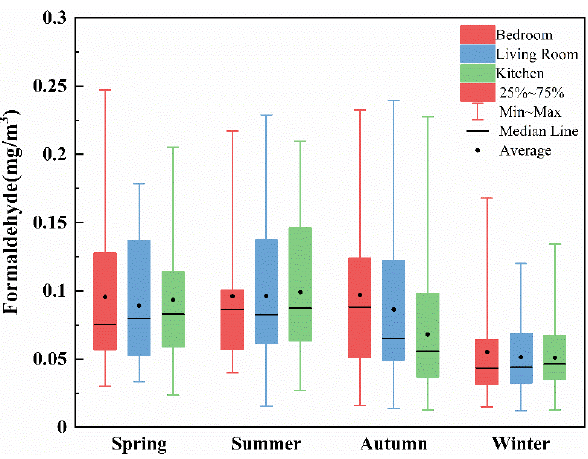
Figure 3. Indoor formaldehyde concentrations of 29 households over different seasons. Table 5. Over-standard rate of formaldehyde concentrations in 29 households.